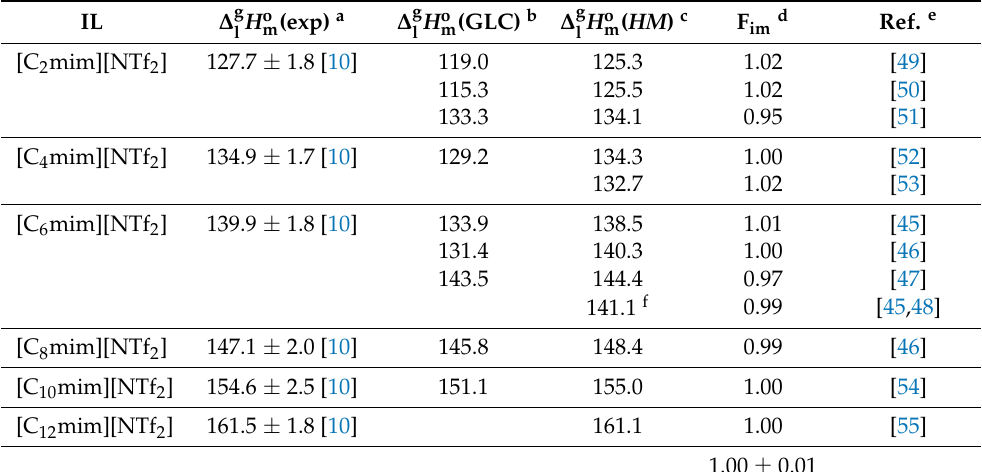
Table 1. [C n mim][NTf 2 ] series: comparison of ∆ g Equations (5) and (6) with experimental results from conventional methods.